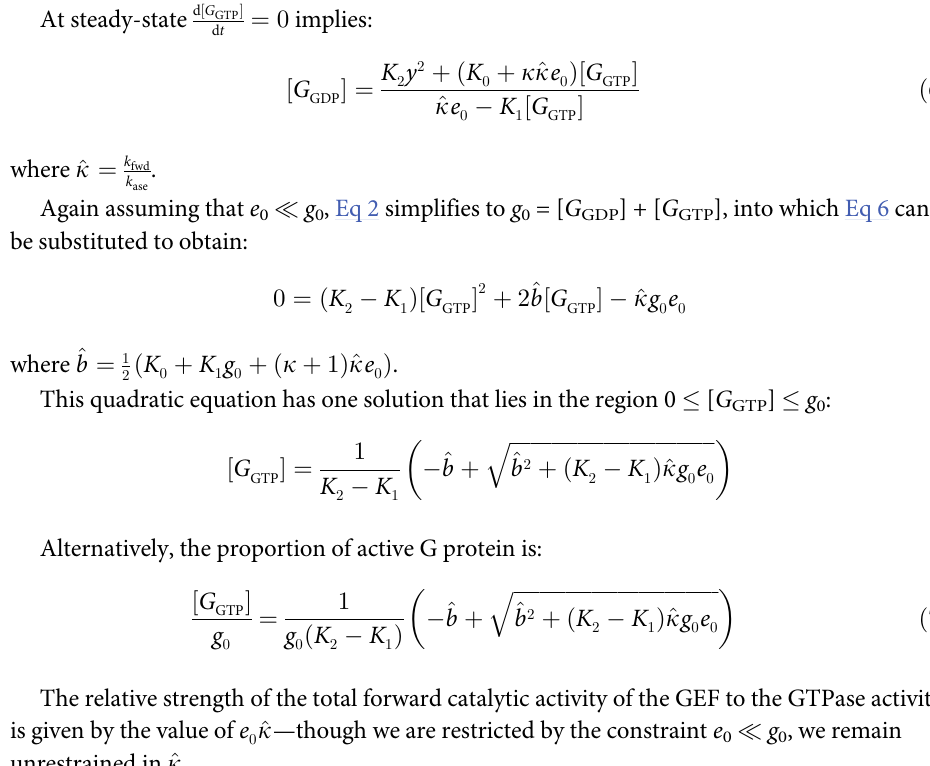
S1 Table. Concentrations, kinetic parameters, and summary parameters used for Figs 2 and